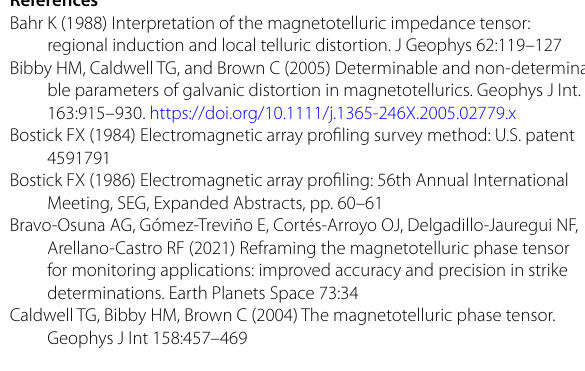
Fig. 16 Invariant apparent resistivities and phases for site lit902 of the BC87 dataset. They correspond to a strike of 62° assuming that ρ associated with Z